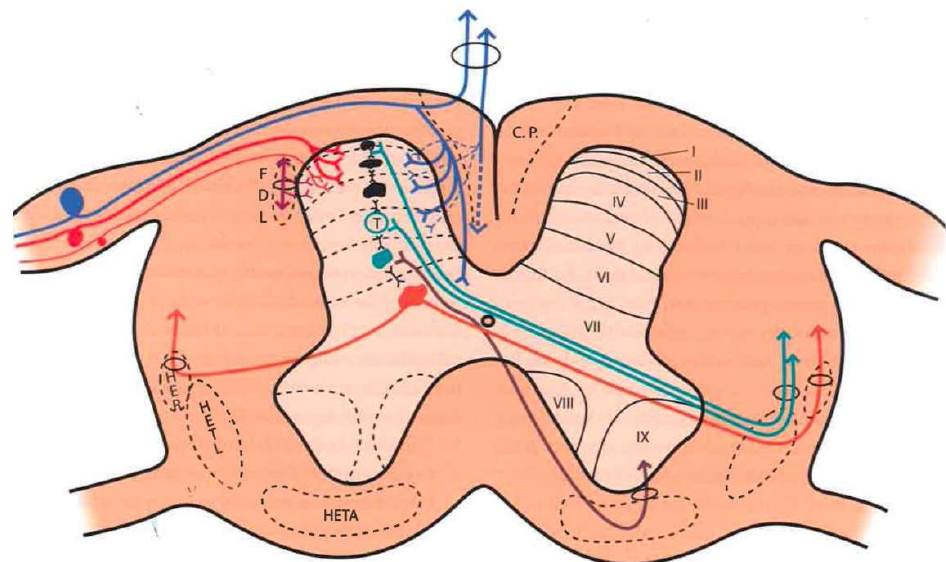
Figure 1. Distribution of afferent pathways in the spinal cord (see text). (Taken from [16]). C.P. = P.C. (Posterior cord). HER = SRT (Spinoreticular tract). HETL = LSTT (Lateral spinothalamic tract). HETA = VSTT (Ventral spinothalamic tract). FDL = DLF (Dorsolateral fasciculus, Lissauer’s tract). I-IX = Laminae of spinal cord gray matter.